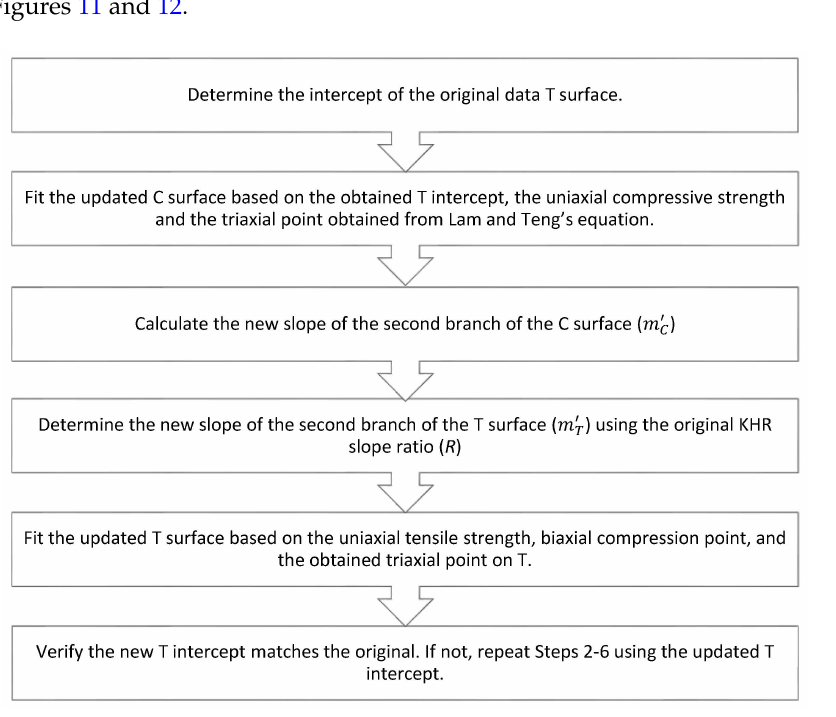
Figure 9. Triaxial model calibration